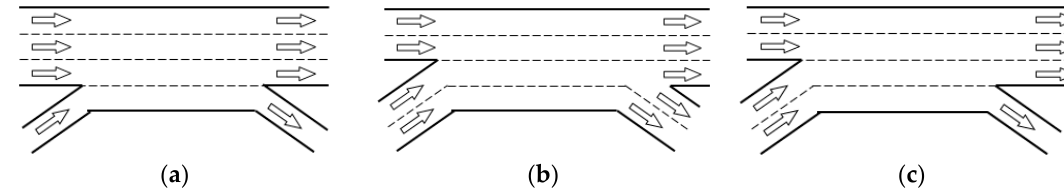
Figure 1 . Three types of weaving sections. ( a ) Type A weaving section; ( b ) Type B weaving section ; ( c ) Type C weaving section.